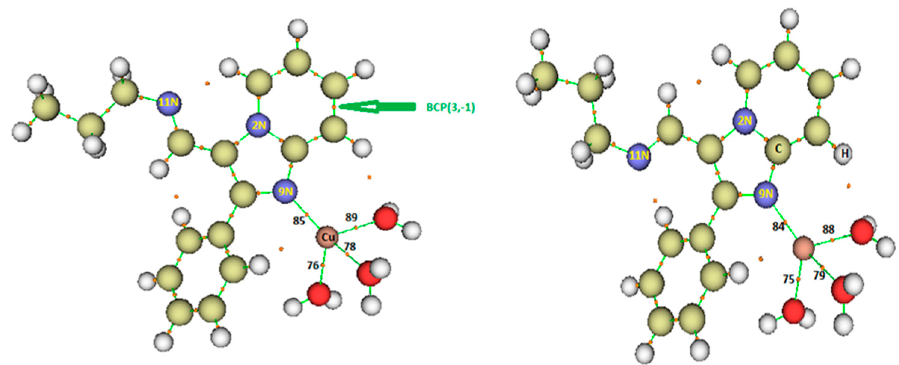
Figure 13. Optimized structures and BCP (bond critical points) for two complexes 1 ( left ) and 2 ( right ).